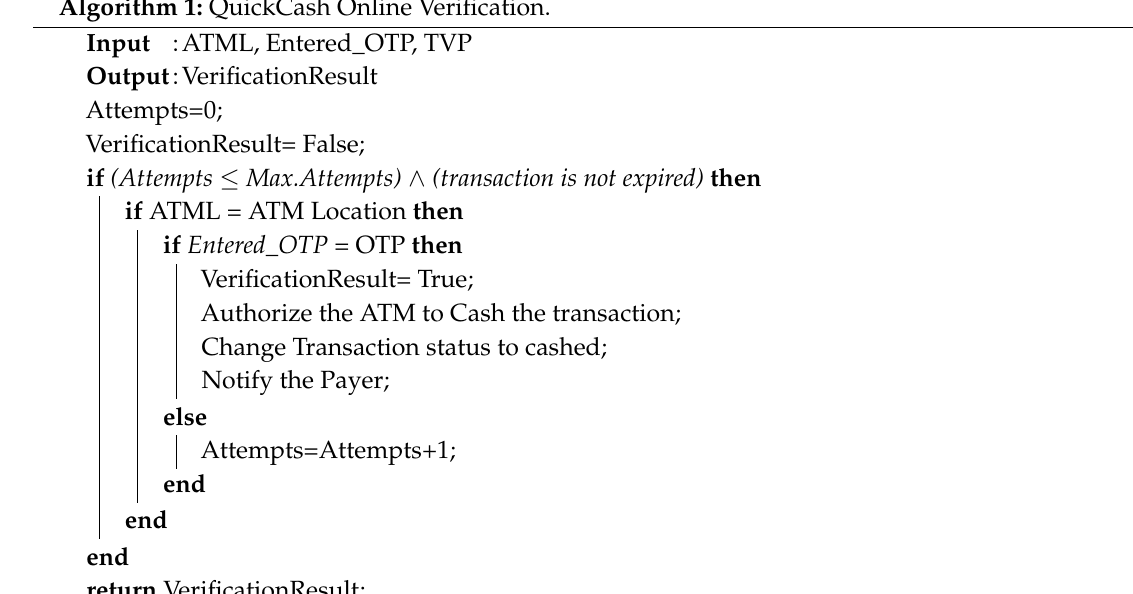
Algorithm 1: QuickCash Online